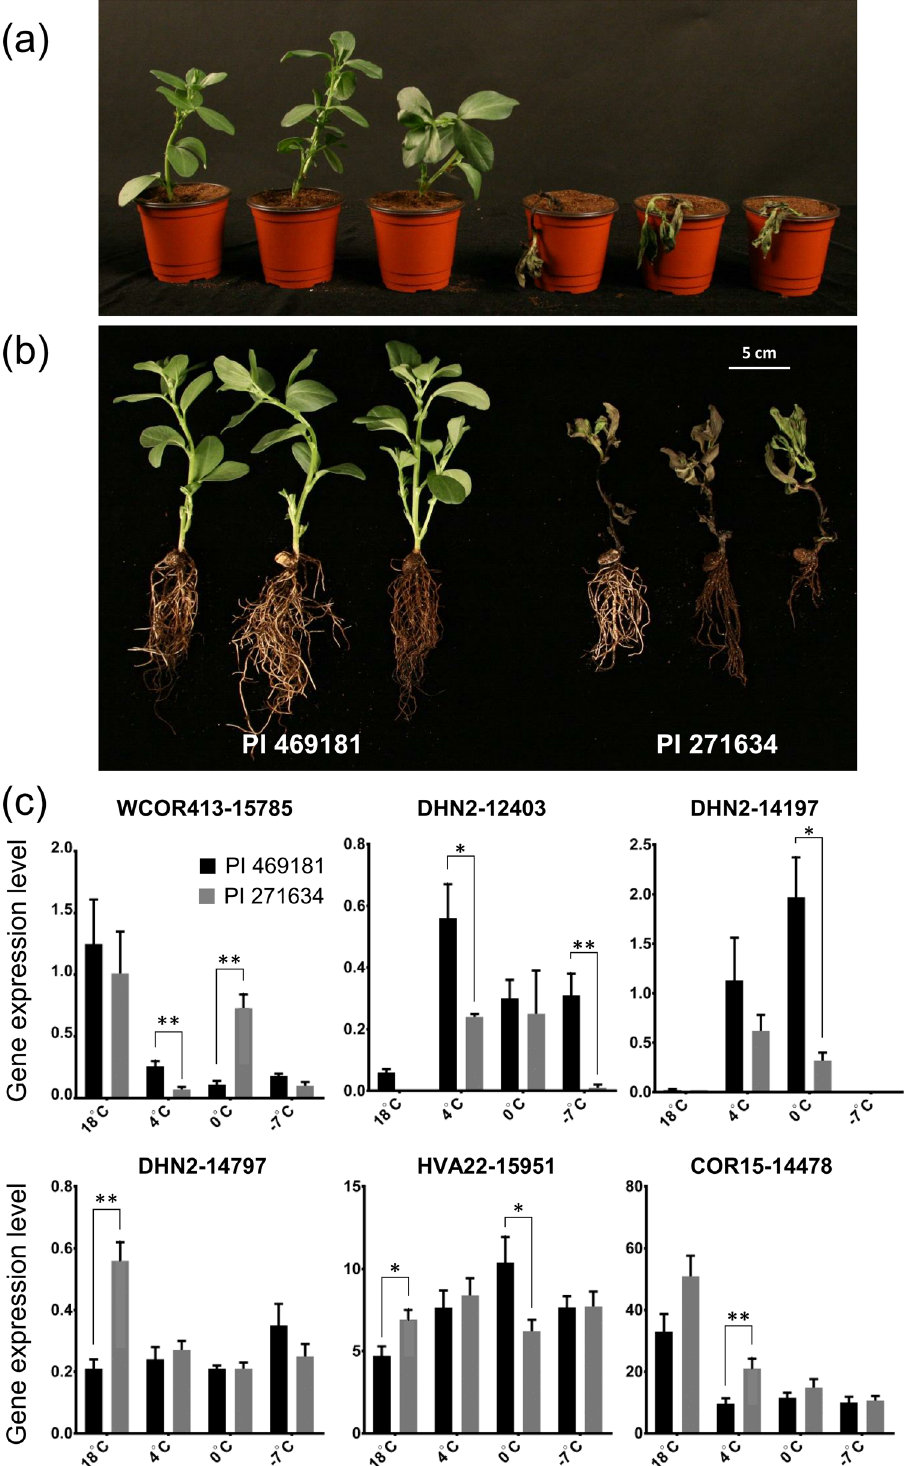
Figure 6. Plant development and expression of cold-related genes in response to cold stress treatment. ( a ) Shoot and ( b ) root development at 4 and − 7 °C. ( c ) Expression levels of candidate cold tolerance genes were determined from the PacBio data. PI 469181 (winter type); PI 271634 (spring